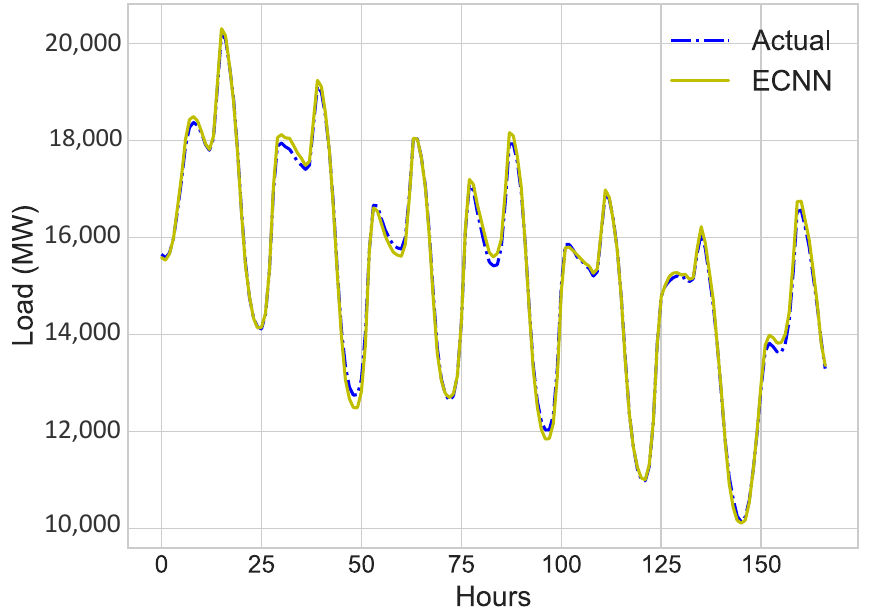
Figure 8. One Week Load